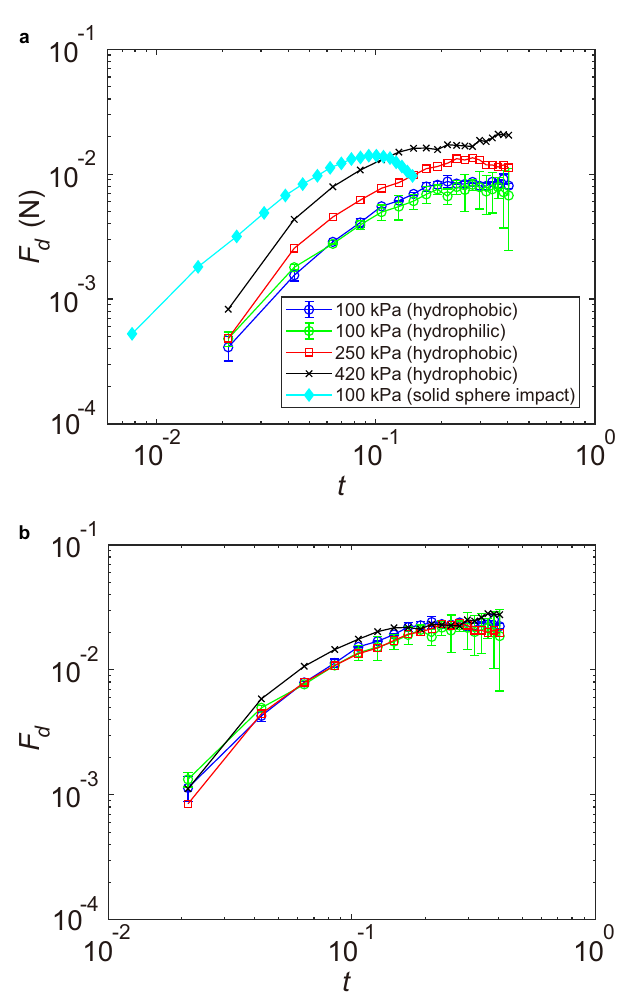
Fig. 5 Shear force of drop impact. a The shear force F d ( t ) of drop impact and solid-sphere impact on the impacted surface of different Young ’ s moduli and wettability. The leftmost curve is for solid-sphere impact and the rest are for drop impact as indicated in the legend. b The dimensionless = 2 D 2 shear force F d of drop impact scaled by E 1 = 2 ð ρ U 2 Þ 1 , as suggested by the theoretical analysis of drop impact on elastic substrates (SI Section 3). The diameter and the impact velocity of the liquid drop are D = 3.49 mm and U = 2.97 m/s. D = 3.16 mm and U = 0.49 m/s for the